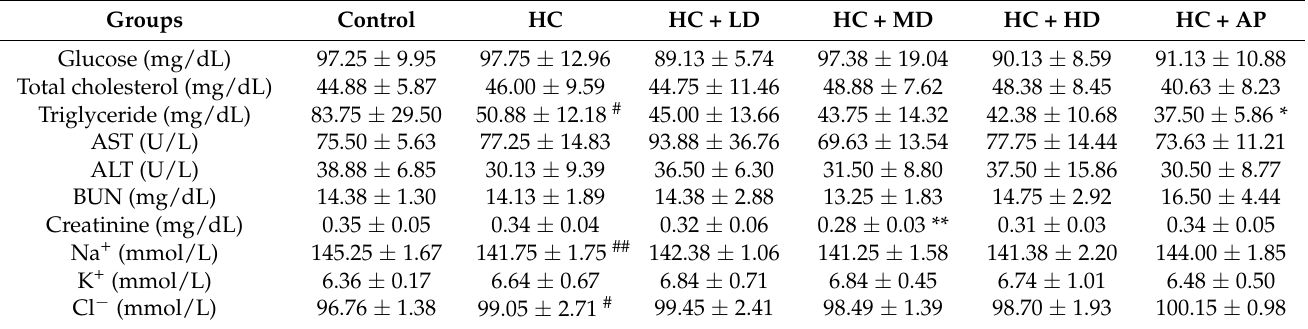
Table 3. Effects of TCI227 on serum biochemical parameters in PO-induced hyperuricemia SD